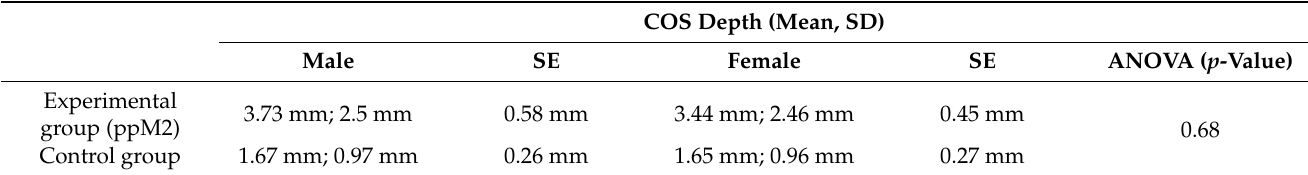
Table 3. COS depth and